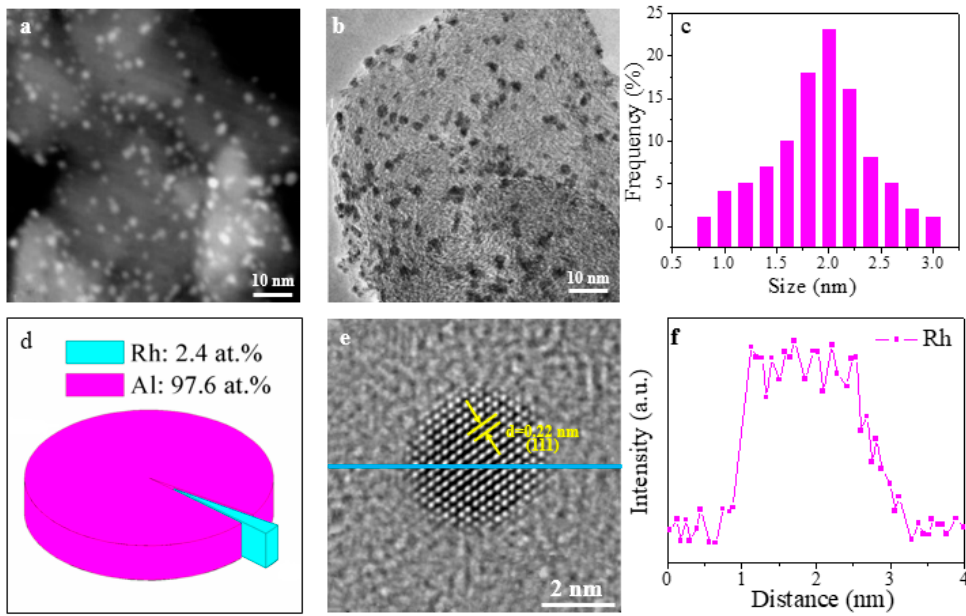
Figure 2. TEM characterization of Rh/ γ -Al 2 O 3 catalysts synthesized by ALD: ( a ) STEM image; ( b ) TEM image ( c ) Rh size distribution; ( d ) Rh/Al atomic ratio based on the EDX data; ( e ) HRTEM image; ( f ) EDX spectrum.